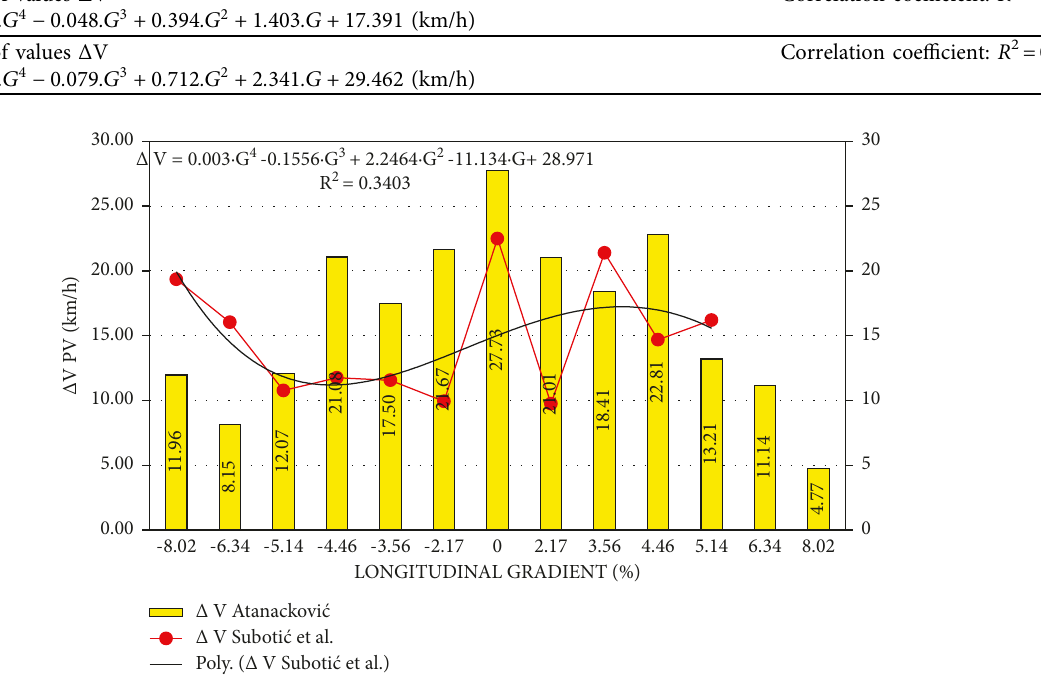
Figure 6: Comparative overview of Δ V for PV in Serbia ( Δ V Atanackovi´c) and BiH ( Δ V Suboti´c et